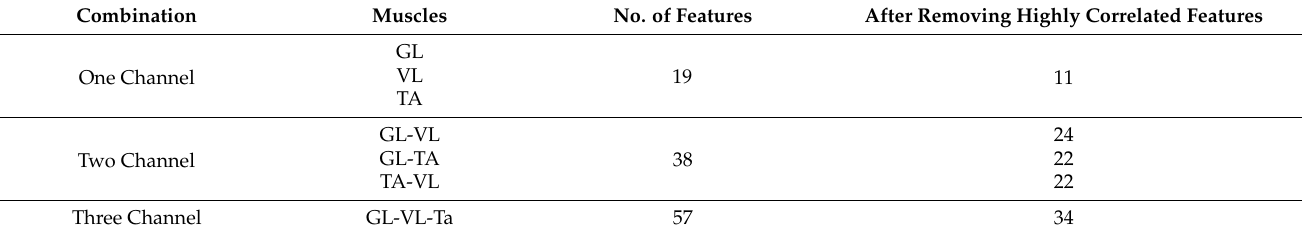
Table 2. Number of features extracted from lower limb muscle EMG for a different combination.